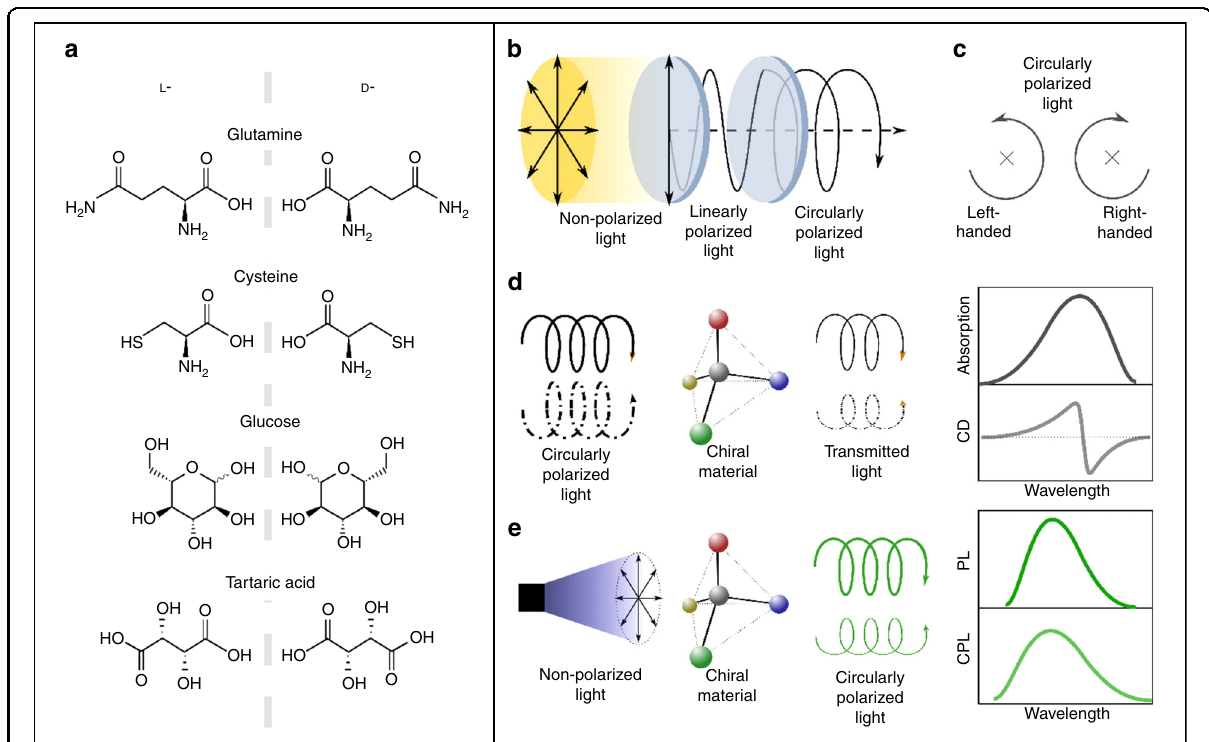
Fig. 1 Optical and molecular principles of chirality and respective measurements. a Examples of chiral organic molecules which have been used in the synthesis of chiral carbon dots. b Illustration of nonpolarized, linearly polarized, and circularly polarized light. c Illustration of left- and right-handed circularly polarized light. d Schematic illustration of CD signal measurements, with idealized absorption and CD spectra shown on the right. e Schematic illustration of CPL signal measurement, with idealized PL and CPL spectra shown on the